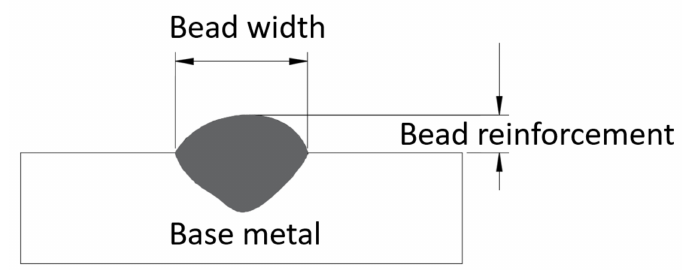
Figure 2. Weld bead geometry.